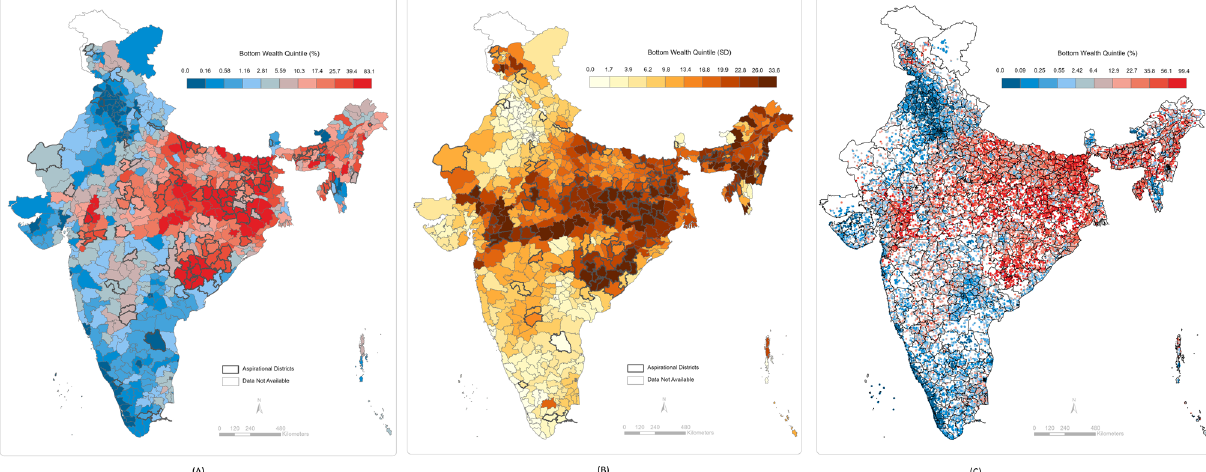
Fig. 6 Small area maps of households in the bottom 20th wealth percentile throughout India. A Geographic prevalence of bottom 20th wealth percentile individuals across 640 districts in India. B District-level distribution of cluster-level inequality for bottom 20th wealth individuals across 640 districts in India. C Geographic prevalence of bottom 20th wealth percentile individuals across 30,170 clusters in